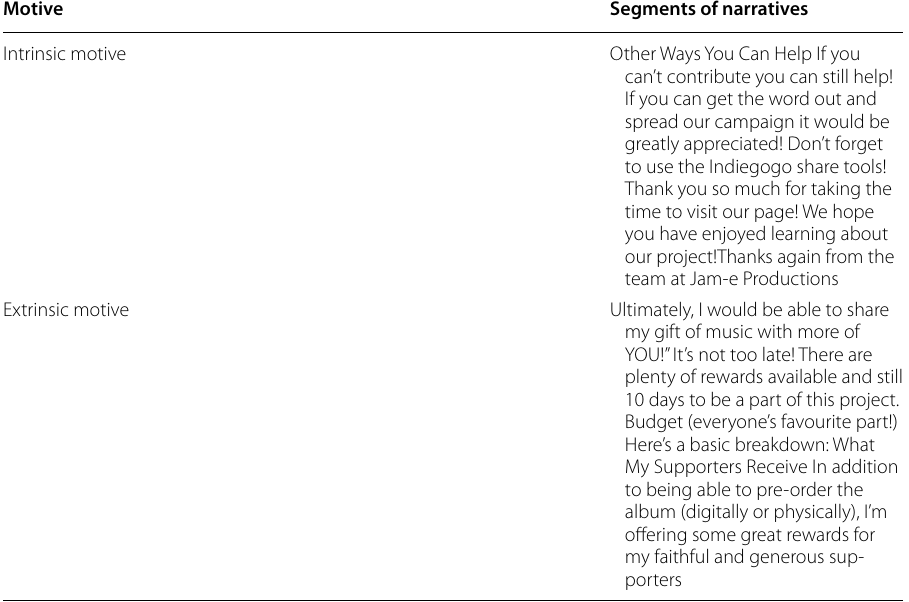
Table 3 Samples of motivational cues Motive